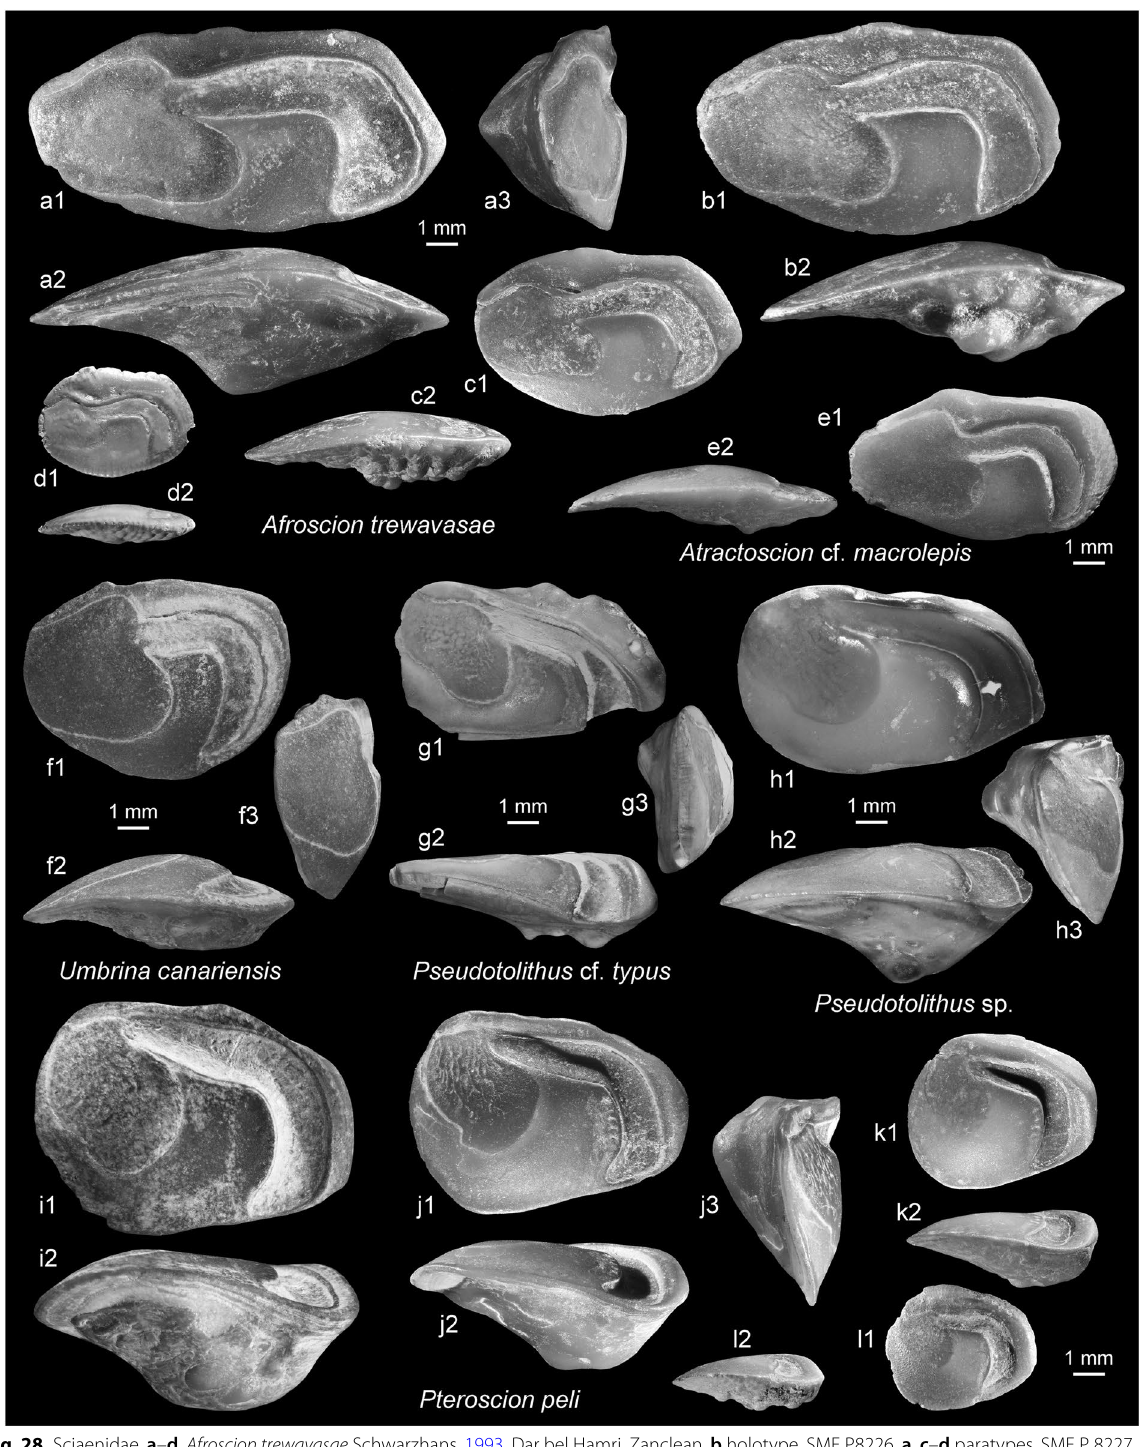
Fig. 28 Sciaenidae. a – d , Afroscion trewavasae Schwarzhans, 1993, Dar bel Hamri, Zanclean, b holotype, SMF P8226, a , c – d paratypes, SMF P 8227 (reversed). e Atractoscion cf. macrolepis Song, Kim & Kim, 2017, SMF PO 101.296, Dar bel Hamri. f Umbrina canariensis Valenciennes, 1843, SMF PO 101.272 (reversed), Dar bel Hamri. g Pseudotolithus cf. typus Bleeker, 1863, SMF PO 101.270, Dar bel Hamri. h Pseudotolithus sp., SMF PO 101.271 (reversed), Dar bel Hamri. i – l Pteroscion peli (Bleeker, 1863), types of Pteroscion maroccanus Schwarzhans, 1993, Dar bel Hamri, Zanclean, h holotype, SMF P 8599, i – k paratypes, SMF P 8600 ( k – l